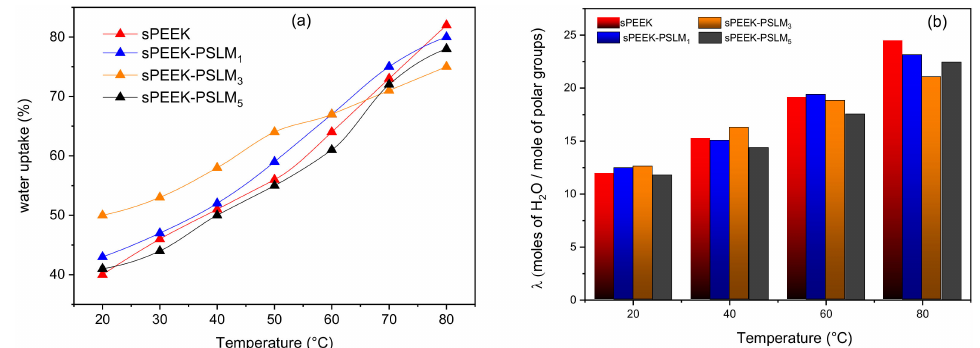
Figure 4. Temperature evolution of ( a ) the water uptake and ( b ) λ for pristine sPEEK and sPEEK- PSLM composite